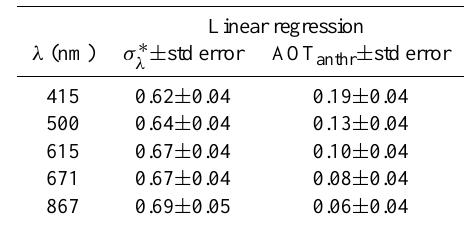
Table 1. Results from linear regression analysis between AOD from the MFR at five wavelengths and dust loading from the BSC- DREAM model, during dust events. The slope gives the extinction cross-section for dust and the intercept expresses the contribution of anthropogenic